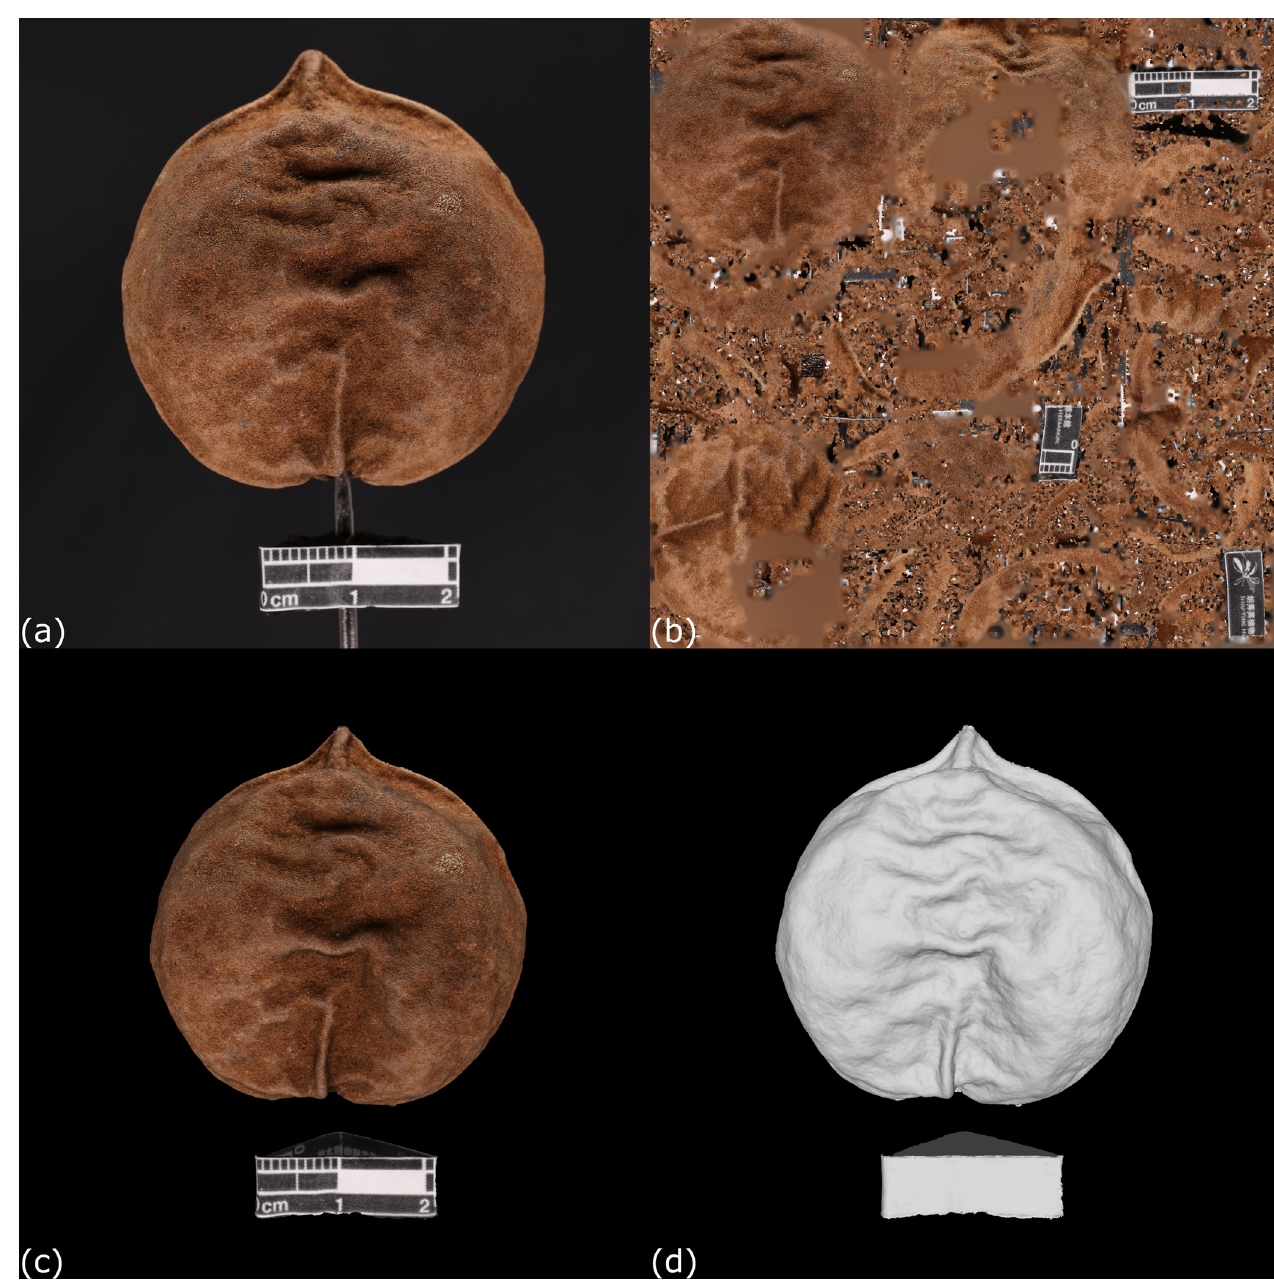
Fig 3. Composition of a 3D model reconstructed by photogrammetric platform. (a) A carpological material of the fruit of Aleurites moluccana (Linnaeus) Willdenow (PH005). (b) Texture of the 3D model extracted by 3DF Zephyr Lite. (c) A 3D model with texture to show the genuine color of PH005. (d) A 3D model without texture to show the plain mesh of